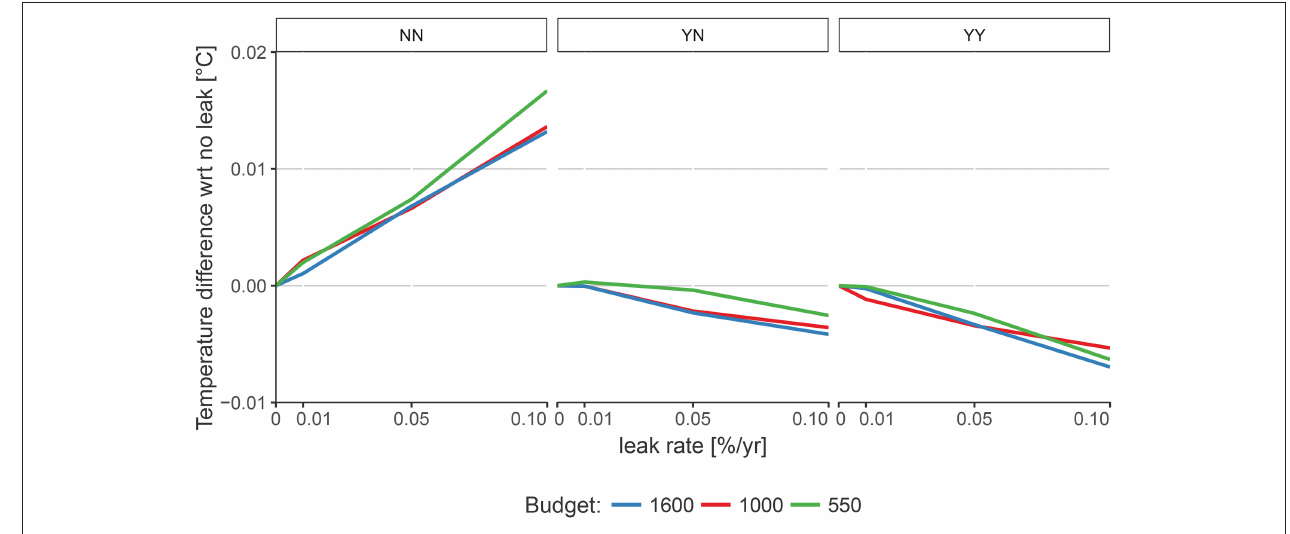
FIGURE 3 | Global mean temperature increase compared to no leakage case [°C].